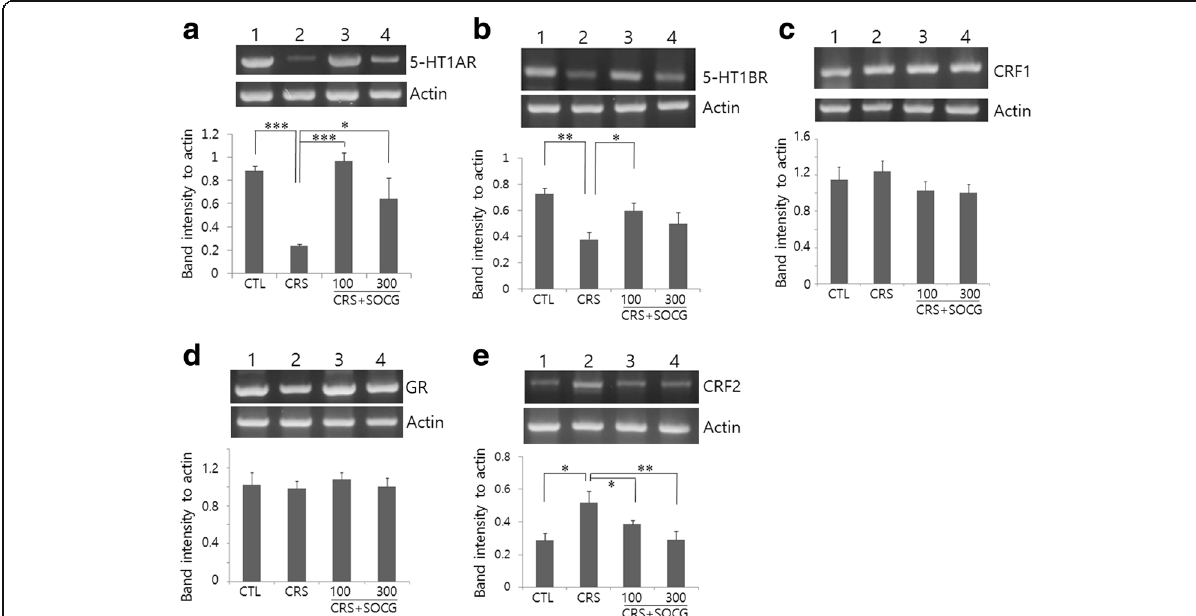
Fig. 1 RT-PCR analysis for the expression of stress-related genes in the hippocampus. Hippocampal mRNA from different animal groups was used for RT-PCR using primers of 5-HT1AR ( a ), 5-HT1BR ( b ), CRF1 ( c ), glucocorticoid receptor (GR; d ), and CRF2 ( e ). RT-PCR for actin mRNA was performed as a loading control. For all figures a through e , lane 1, CTL; lane 2, CRS; lane 3, CRS + 100 mg/kg SOCG; lane 4, CRS + 300 mg/kg SOCG. The ratio of band intensity of each mRNA to actin was shown by bar graphs ( n = 4). * P < 0.05, ** P < 0.01, *** P < 0.001 (One-way ANOVA, n = 4)